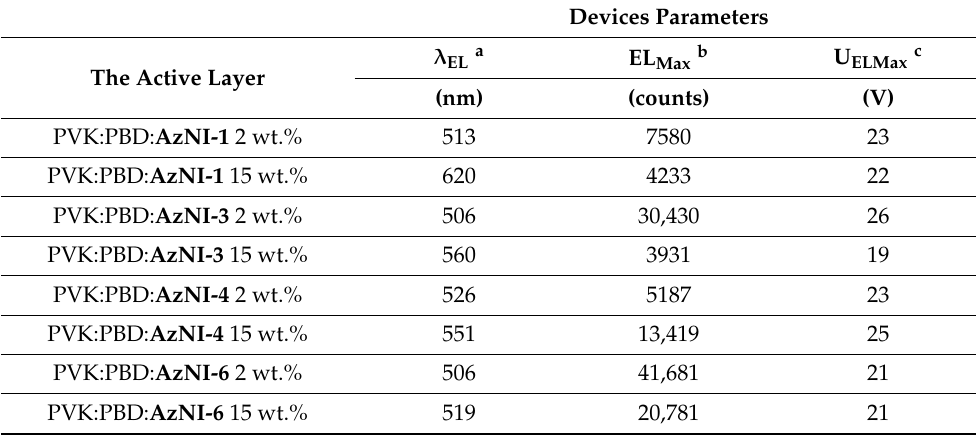
Devices Parameters